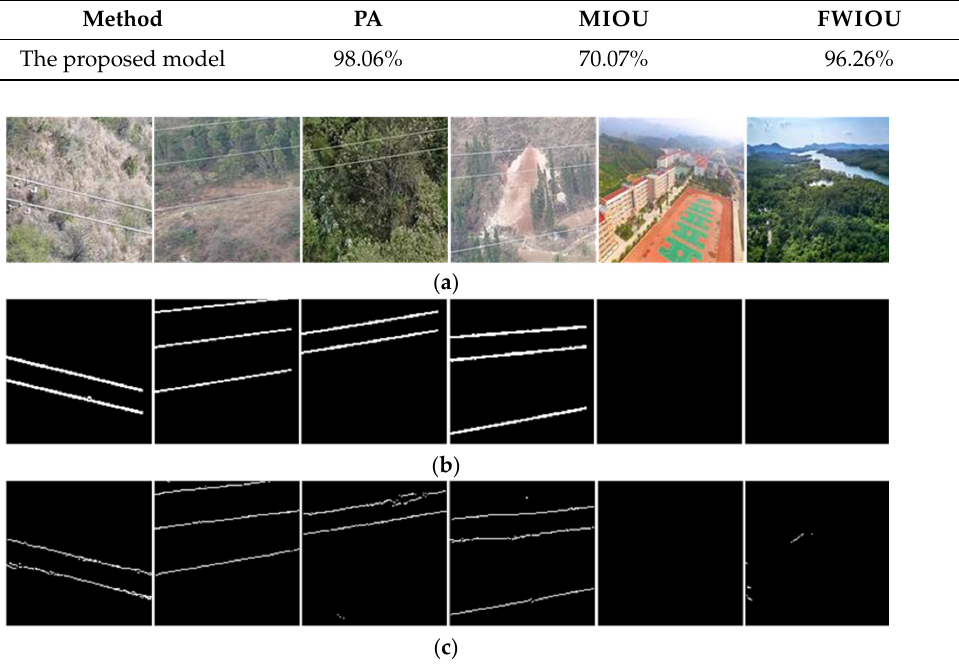
Figure 10. Generalization test results by using the proposed PLE method. The first four contain the power line scene, and the last two do not contain power line scene (order from left to right). ( a ) Images used for generalization test. ( b ) Ground truth. ( c ) Results of the proposed PLE model.